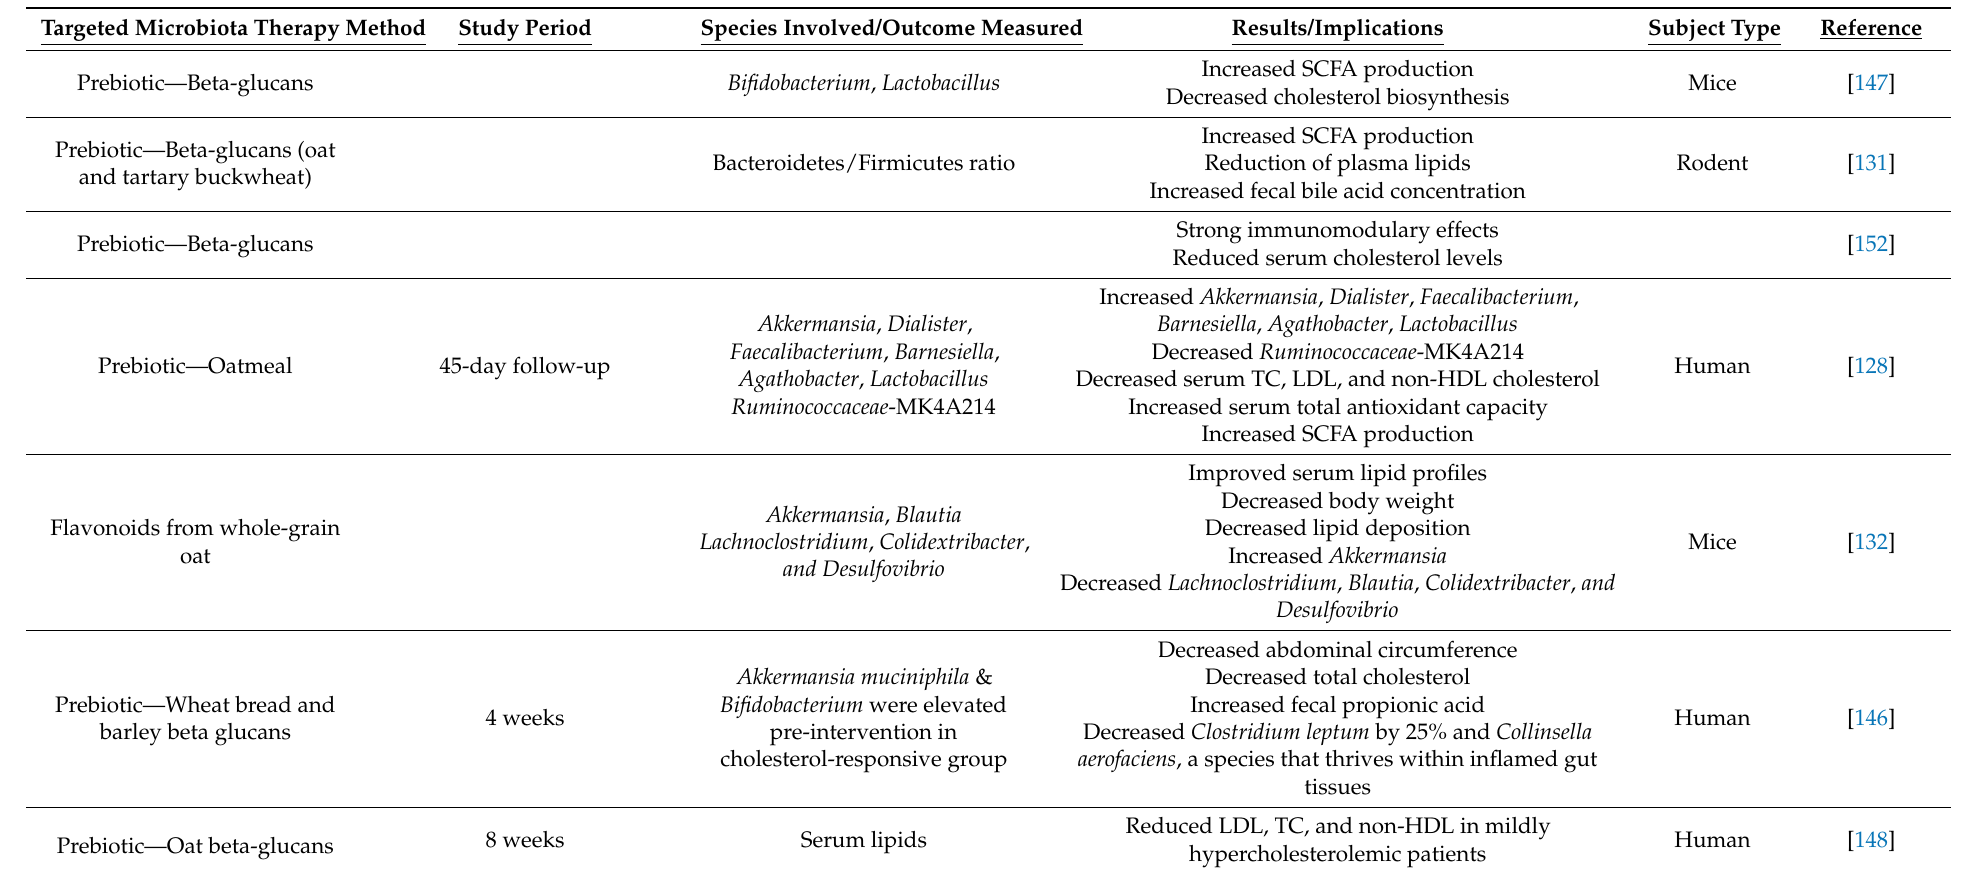
Table 1. Targeted Microbiota therapy studies, outcomes, results, and